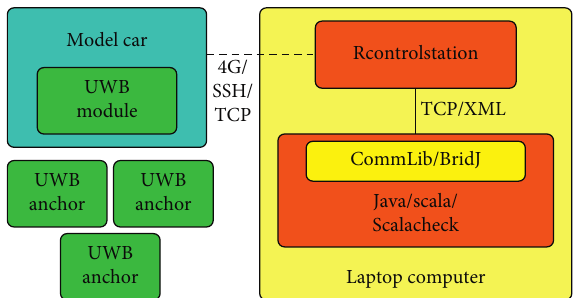
Figure 3: Experimental setup consisting of a laptop computer, our model car, and two or more of our UWB anchors.